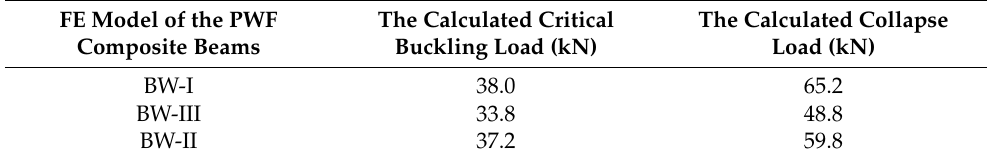
Table 15. The critical buckling loads and the collapse loads of the BW-I~III models form the FE